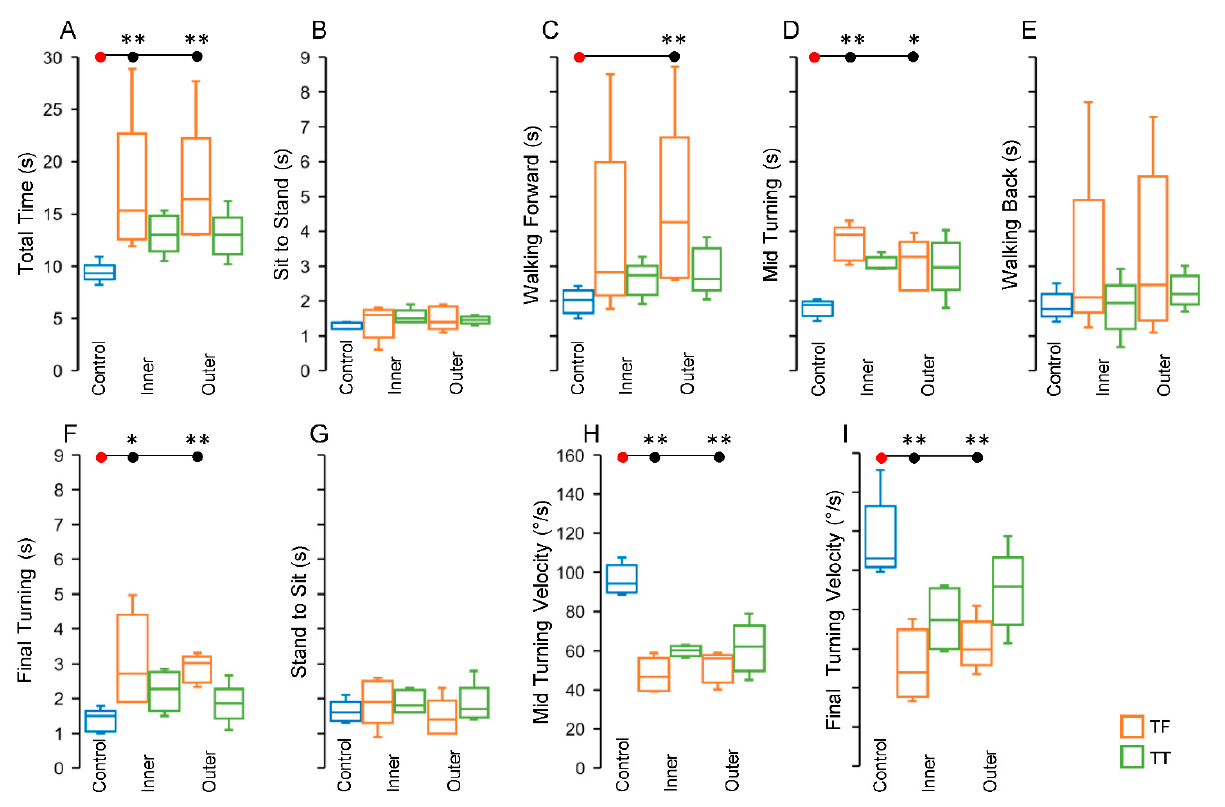
Figure 5. Box and whisker plots reporting median and variability (as described in Figure 4) of parameters measured during the Timed Up and Go test: Total time ( A ), sit to stand ( B ), walking forward ( C ), mid-turning ( D ), walking back ( E ), final turning ( F ), ( G ) stand to sit, ( H ) mid-turning velocity, ( I ) final turning velocity. Abbreviations as in Figure 4. Symbols: * p < 0.05; ** p < 0.01. Table 3. Descriptive statistics (mean ± standard deviation) for temporal and velocity parameters over the TUG subcomponents, in the persons with lower limb amputation and non-amputated. Temporal Parameters (s) Velocity Parameters ( ◦